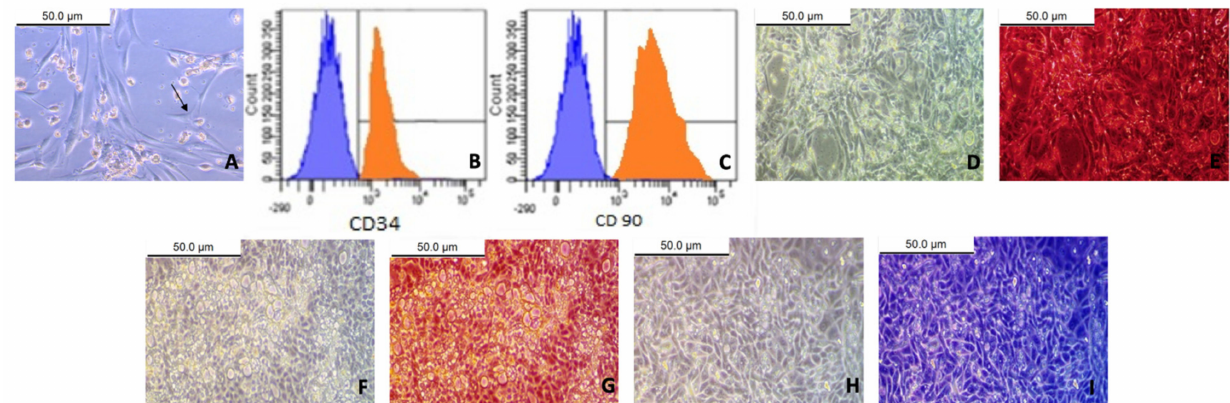
Figure 1. Bone marrow-derived mesenchymal stem cells (BM-MSCs) were distinguished by: fusiform shape (black arrow) ( A ); FACS: cells were uniformly negative for CD 34 − and weakly expressed (1.8%) ( B ) and uniformly positive for CD90 + and strongly expressed (98.2%) ( C ); Differentiation: MSCs differentiated into osteocytes and presented before staining ( D ) and after staining with Alizarin red ( E ) ( × 40); MSCs differentiated into adipocytes and presented before staining ( F ) and after staining with Oil Red O ( G ) ( × 40); MSCs differentiated into chondrocytes and presented before staining ( H ) and after staining with Alcian blue ( I ) ( × 40).